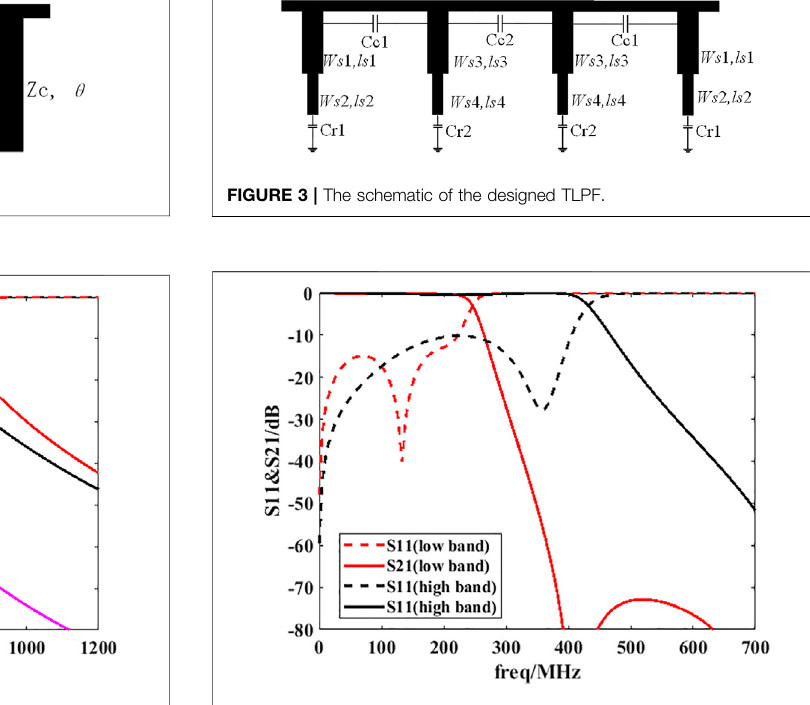
FIGURE 2 | The tuning of the low pass fi lter.